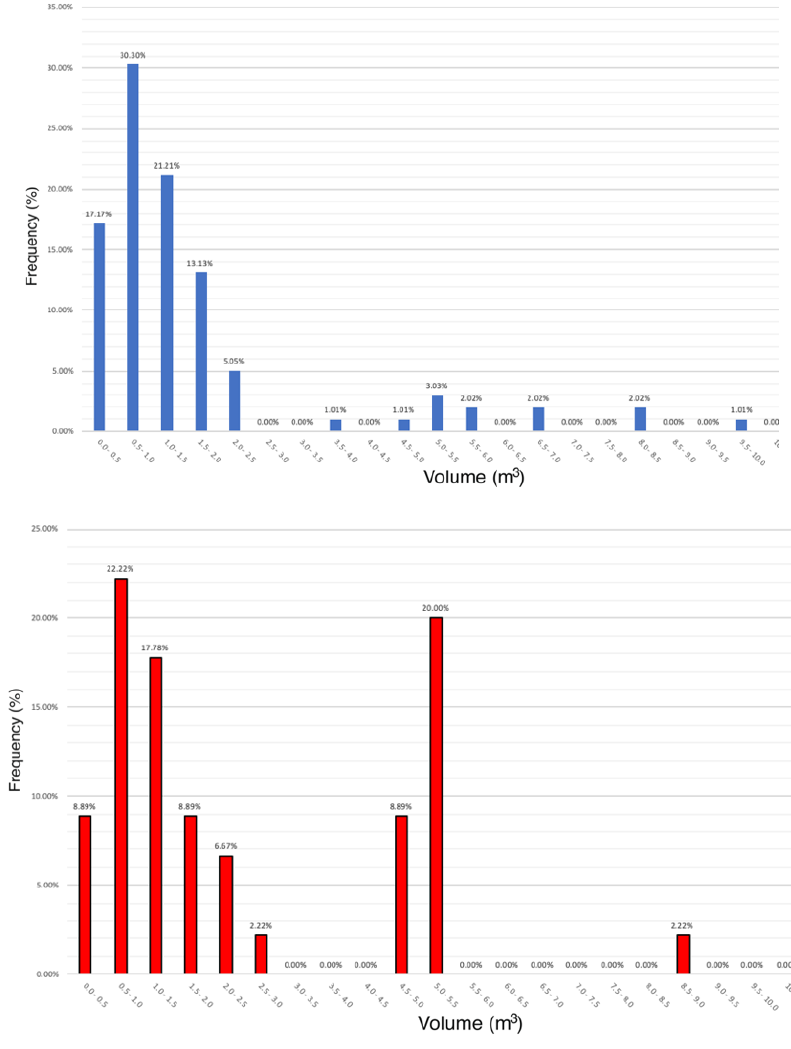
Figure 17. Volume distribution for both the fallen (blue) and the potentially unstable (red) blocks for sub-region U3.